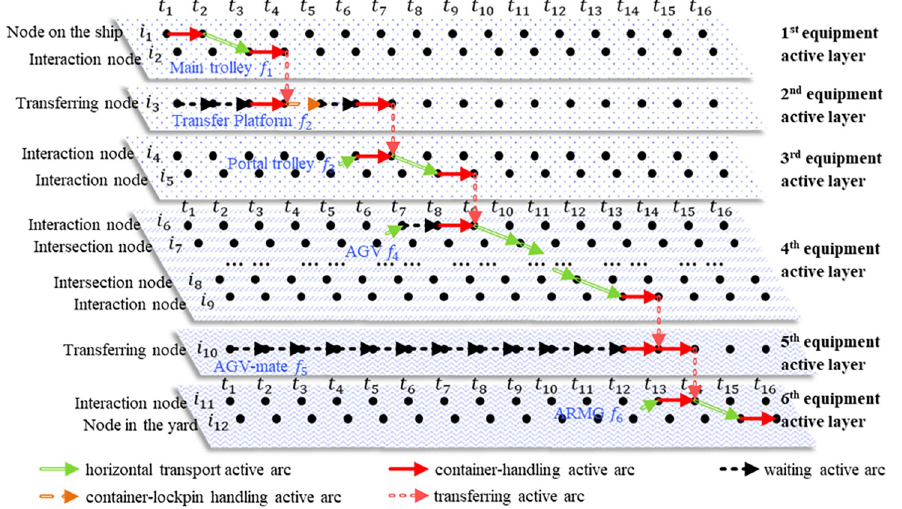
Fig 5. An example of the space-time representation of the container-importing